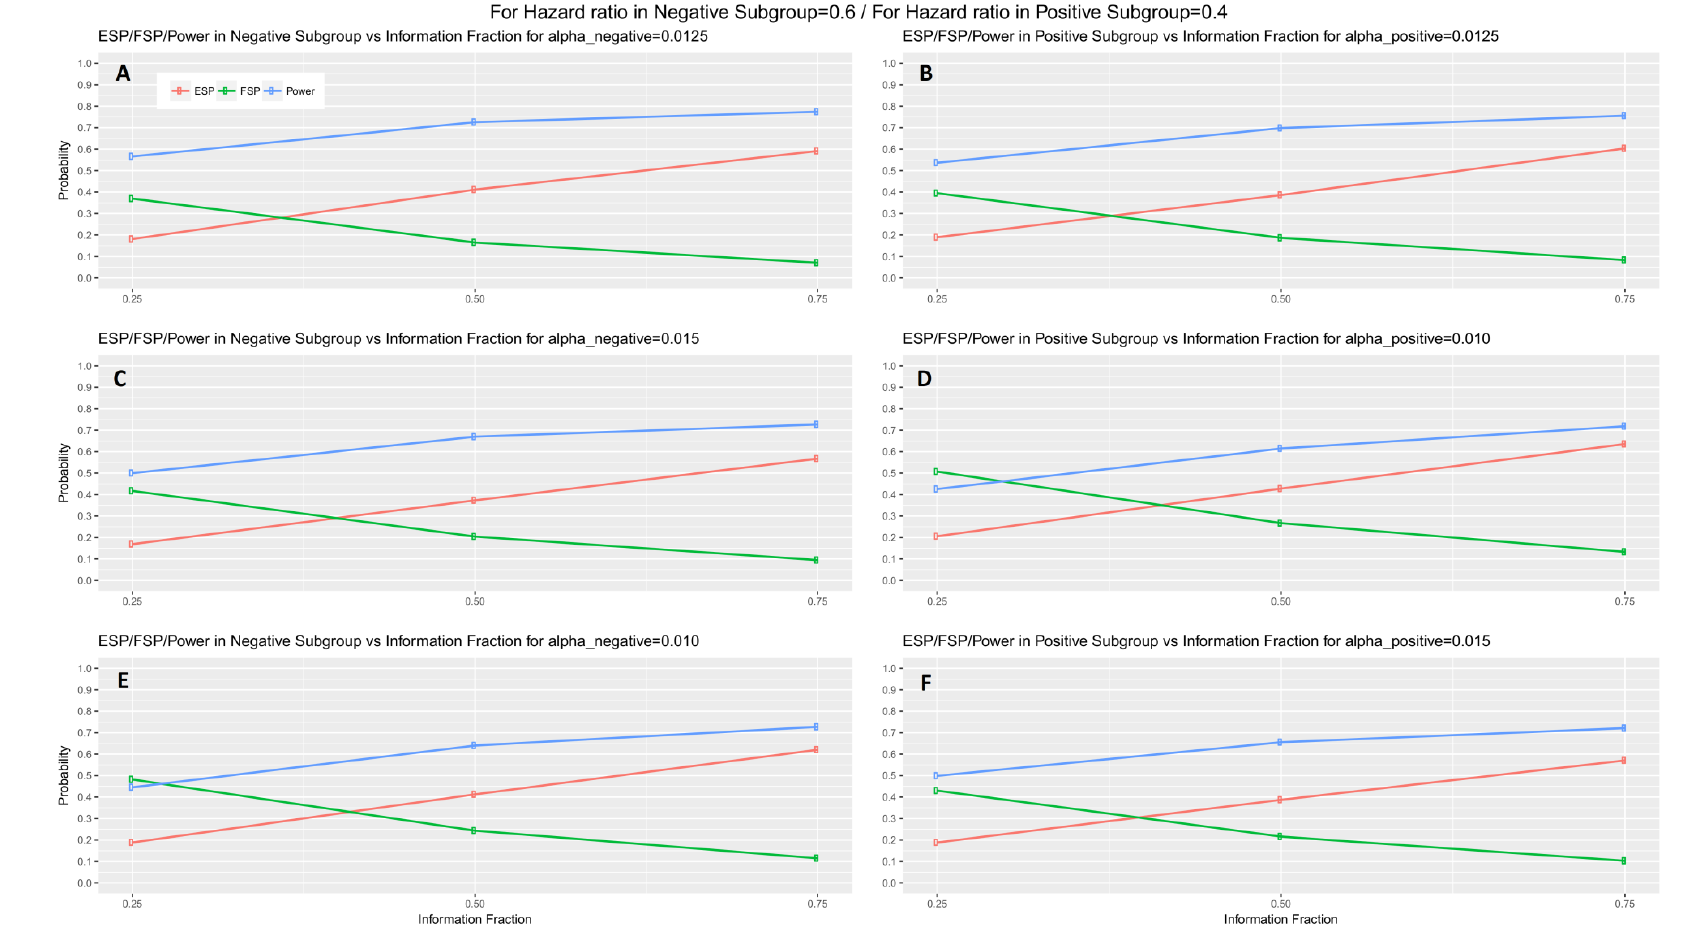
Figure 5. Efficacy stopping probability, futility stopping probability and power of a two-stage design versus the interim fraction (25%, 50%, 75%) in each biomarker-defined subgroup for scenario 1 of hazard ratios. Each row of graphs represents the different probabilities versus the interim fraction of each biomarker-defined subgroup when (i) a − = a + = 0.0125 ( A , B ), (ii) a − = 0.015 and a + = 0.010 in ( C , D ), and (iii) a − = 0.010 and a + = 0.015 in ( E , F )